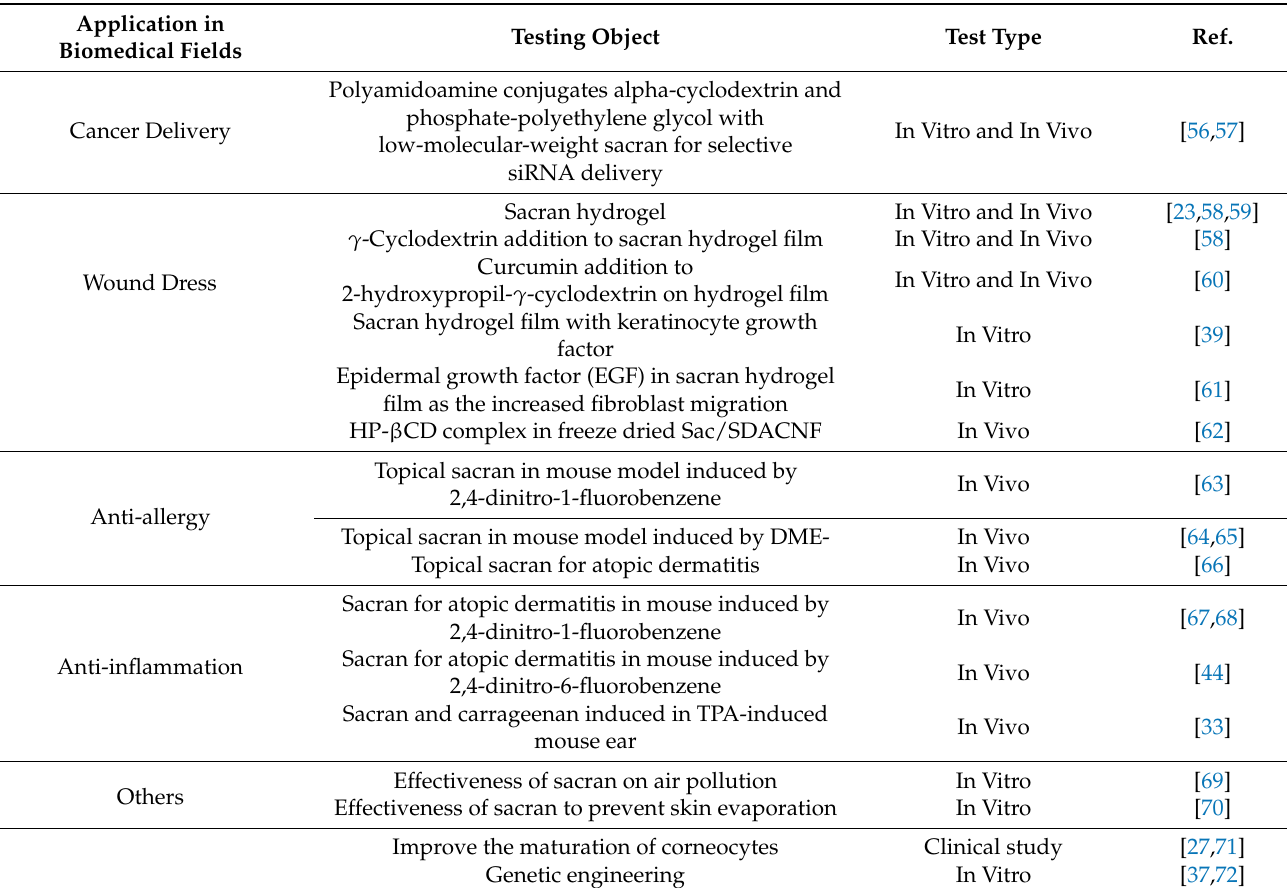
Table 2. Sacran activity testing in biomedical